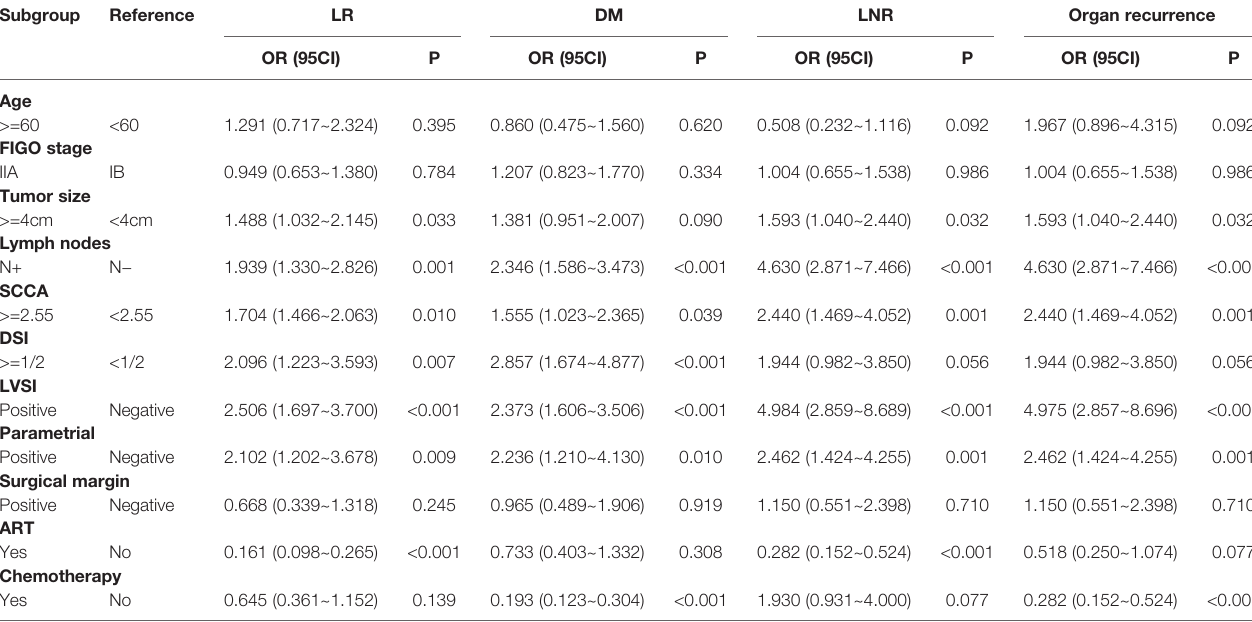
TABLE 2 | Univariate logistic regression models for different recurrence sites and subtypes.